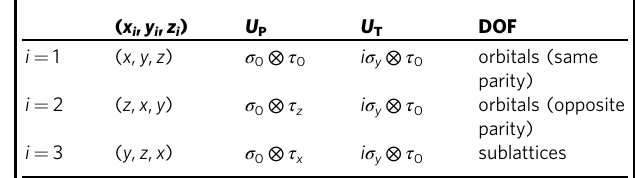
Table 2 Classi fi cation of two-band models based on the extra degrees of freedom (DOF).